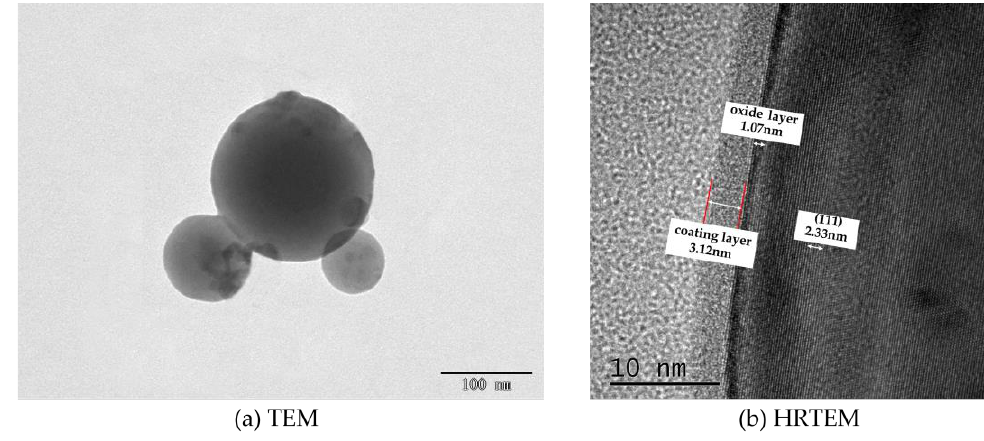
Figure 2. TEM image of C 8 H 18 -Al nanoparticles.